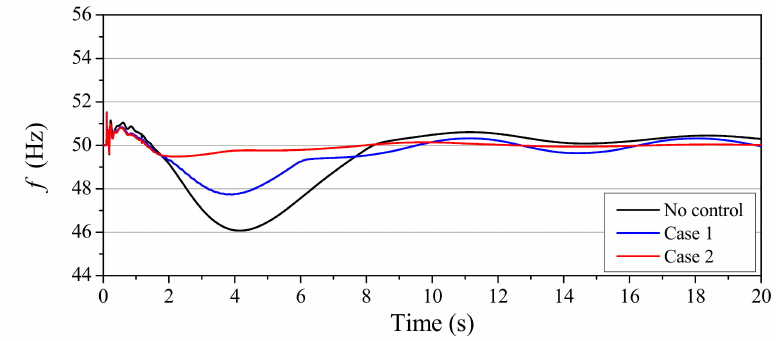
Figure 10. Power system frequency (with SG3 installed).